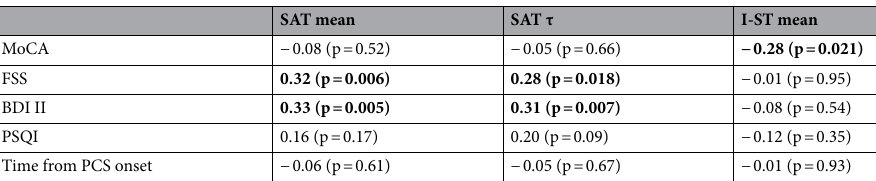
Table 6. Results by Spearman r analysis (r and p-value), for studying the relation of SAT RTs and derived I-ST with clinical and cognitive global scores. MoCA montreal cognitive assessment, FSS fatigue severity